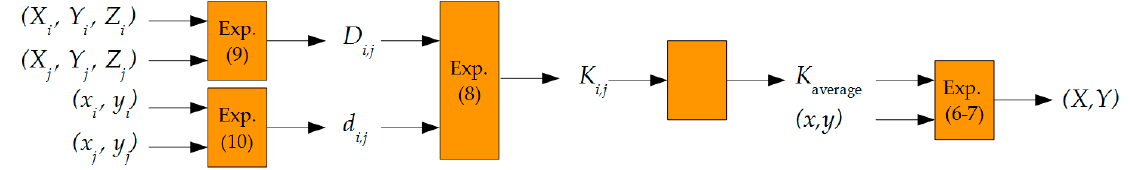
Figure 5. Functional diagram of the quantities and mathematical models related to the proposed optical approach.